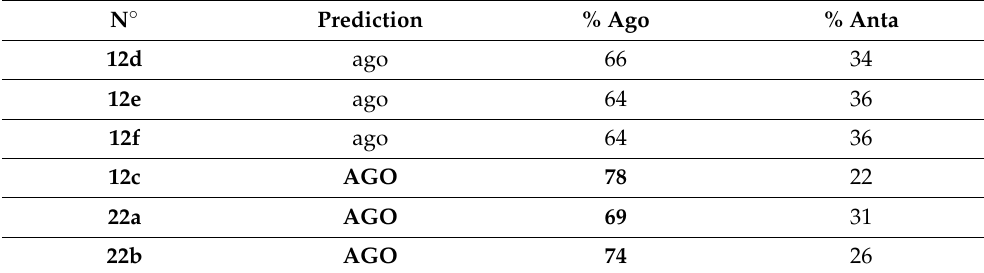
Table 1. Profile prediction obtained by PF model (LDA results).